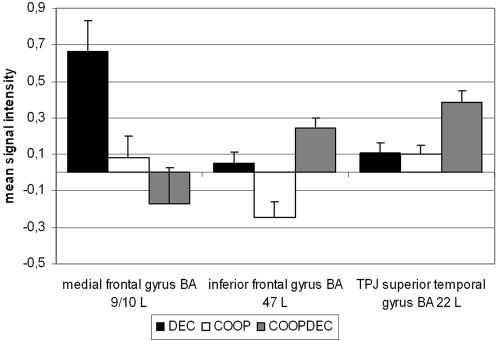
Activation in frontal and temporal regions during the different ToM conditions.The graph shows the mean signal intensity (+/− s.e.m.) (in arbitrary units) in these regions in the conditions DEC (black), COOP (white) and COOPDEC (grey), respectively. The ANOVA with the factors condition and region showed main effects of condition (F(2) = 7.917 p<0.001, region (F(2) = 4.830 p<0.01 and a significant condition*region interaction (F(4) = 9.910 p<0.001 with significantly higher activation in medial prefrontal cortex during DEC compared to COOP and COOPDEC (t(12) = 2.537 p<0.01 and t(12) = 2.290 p<0.01, respectively); in inferior frontal cortex during DEC and COOPDEC compared to COOP (t(12) = 3.041 p<0.01 and t(12) = 4.005 p<0.001), and in temporoparietal junction in COOPDEC compared to DEC (t(12) = 2.079 p<0.01) and COOP (t(12) = 4.173 p<0.001). Activation during DEC was significantly higher in medial PFC than in TPJ (t(12) = 3.179 p<0.01), and during COOP and COOPDEC significantly higher in TPJ than in inferior frontal gyrus (t(12) =  3.726 p<0.01 and t(12) = 2.757 p<0.01).